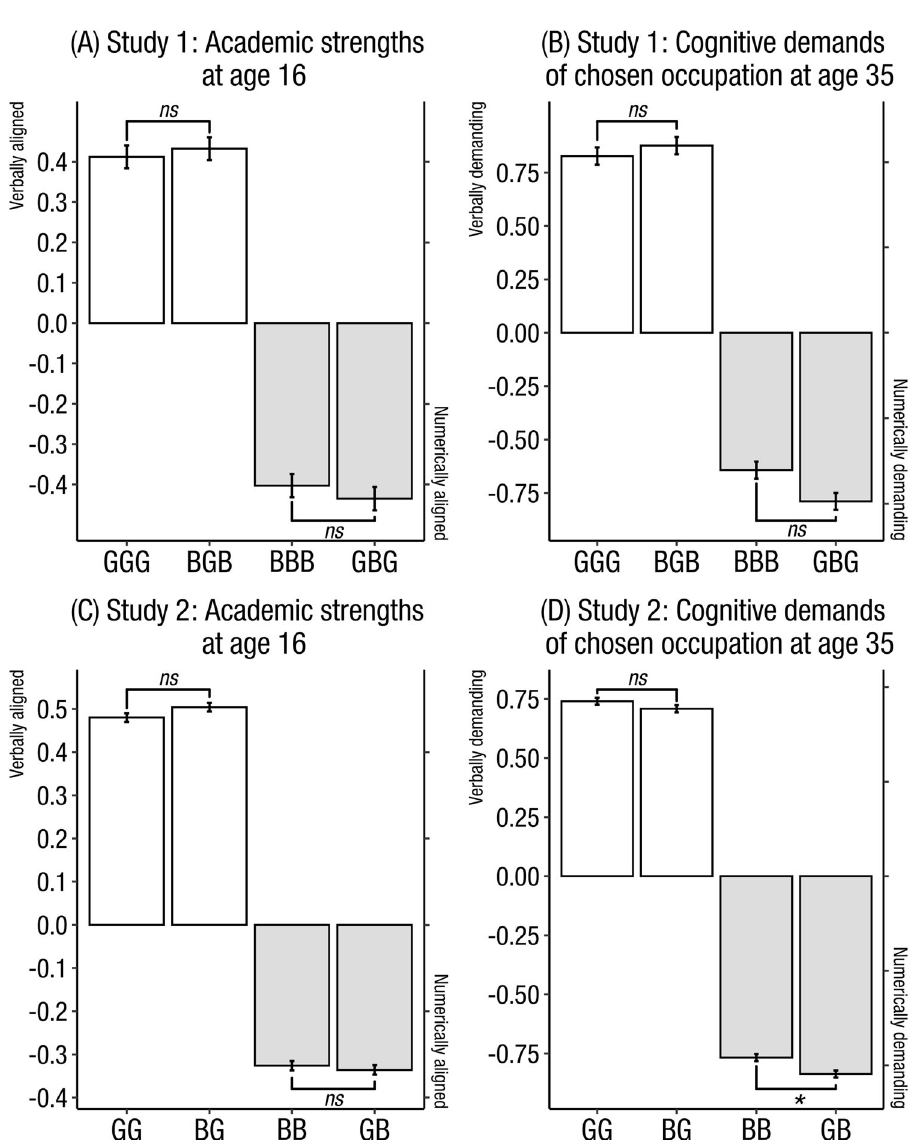
Fig. 1 Illustrations of the academic strengths score and cognitive demands of chosen occupation grouped by sibship composition and sex. Academic strengths at age 16 grouped by sibship composition in A Study 1 and C Study 2. Positive values indicate higher grades in verbal/language subjects, whereas negative values indicate higher grades in numerical/technical subjects. Cognitive demands of chosen occupation at age 35 grouped by sibship composition in B Study 1, and D Study 2. Positive values indicate higher verbal demands in occupation, whereas negative values indicate higher numerical demands in occupation. GGG = Mid-born girls with younger and older sisters; BGB = Mid-born girls with younger and older brothers; BBB = Mid-born boys with younger and older brothers; GBG = Mid-born boys with younger and older sisters. Note : All means are adjusted for GPA, mother\s age at birth, mother\s education level, sibship type, ethnicity (Swedish or other), and age differences between the siblings. Whiskers represent the standard error of the mean. ns = not signi fi cant; * p <